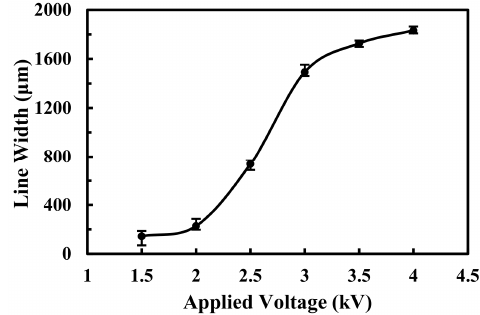
Figure 3. The effect of applied voltage on the electrospray line width. The flow rate of solution, the velocity of substrate, the distance between nozzle and collector and the deposition time were 50 µ L/h, 5 mm/s, 5 mm and 2 s, respectively.